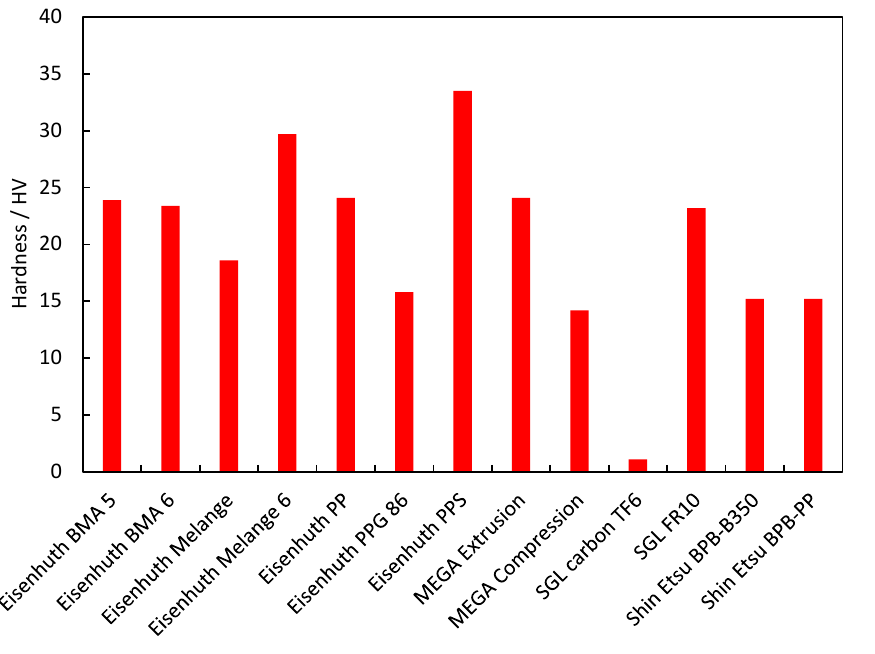
Figure 8. Hardness of the BP materials tested.